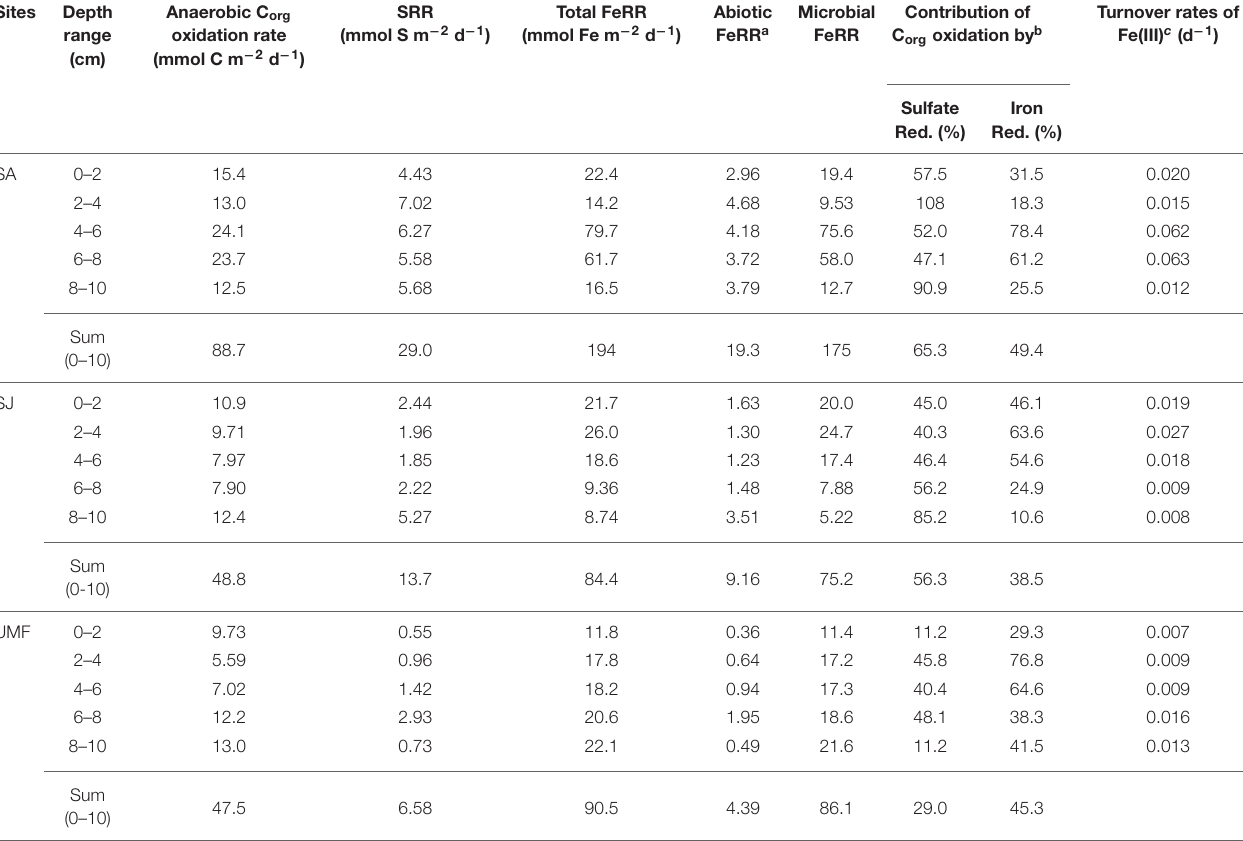
TABLE 3 | Partitioning of sulfate reduction (SRR) and Fe(III) reduction (FeRR) in C org oxidation, and turnover rates of Fe(III). Sites Depth